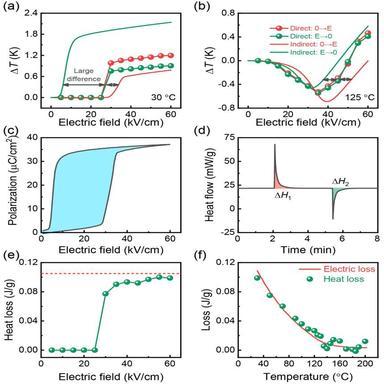
Comparison of ΔT by different EC measurements and data collection methods at (a) 30 ◦C and (b) 125 ◦C. (c) A schematic diagram of a P-E loop for calculating electric loss in AFE ceramics. (d) A schematic diagram of an isothermal heat flow curve for calculating heat loss. (e) The heat loss at 30 ◦C under different electric fields obtained from isothermal heat flow curves. The dotted-line shows the electric loss at 30 ◦C under 60 kV/cm from a P-E loop. (f) A comparison of the electric and heat loss at differe